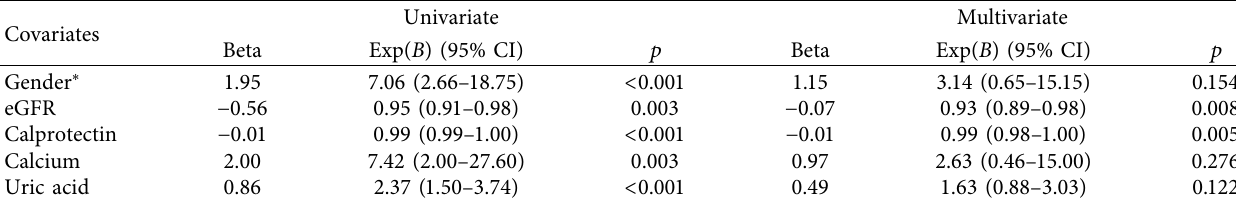
Table 4: Logistic regression for hypertension in the study population.